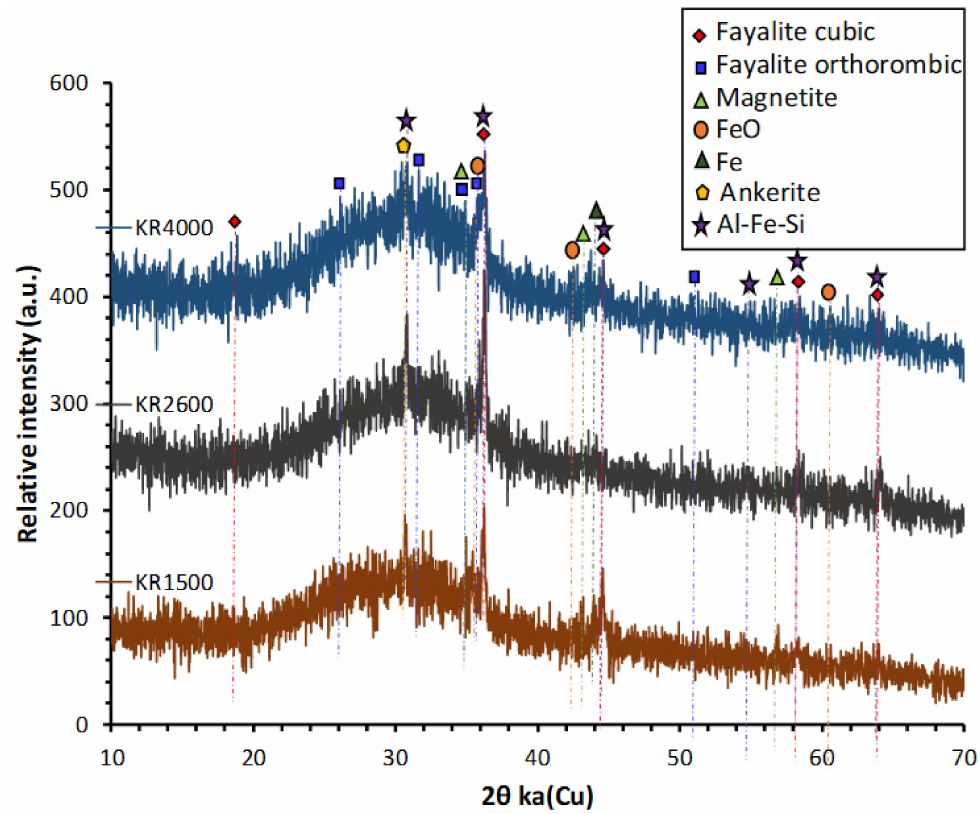
Figure 2. XRD diffractograms of KORANEL®(KR) samples of 1500, 2600 and 4000 Blaine. Table 2. Mix design of the prepared one-part geopolymers. DS and MS stand for sodium disilicate and sodium metasilicate, respectively. CS 2600 is the copper slag with a Blaine of 2600 cm 2 /g. W/P is the water to powder ratio based on the amount of added water; and the real liquid/solid (L/S) is calculated based on added water and water present in the DS/MS. Composition